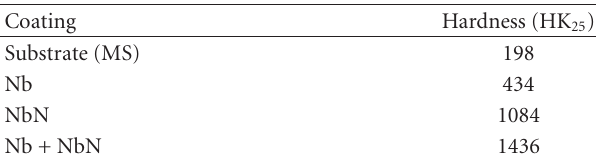
Table 2: Surface hardness of MS, and Nb, NbN, and duplex coatings on